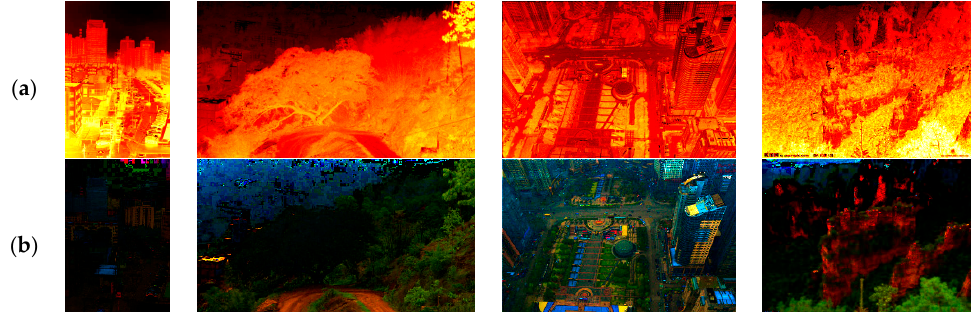
Figure 8. The transmission maps t β estimated using pixel-level DCP and the relevant restored images for Figure 7, top. ( a ): the transmission maps t β . ( b ): the relevant restored images.